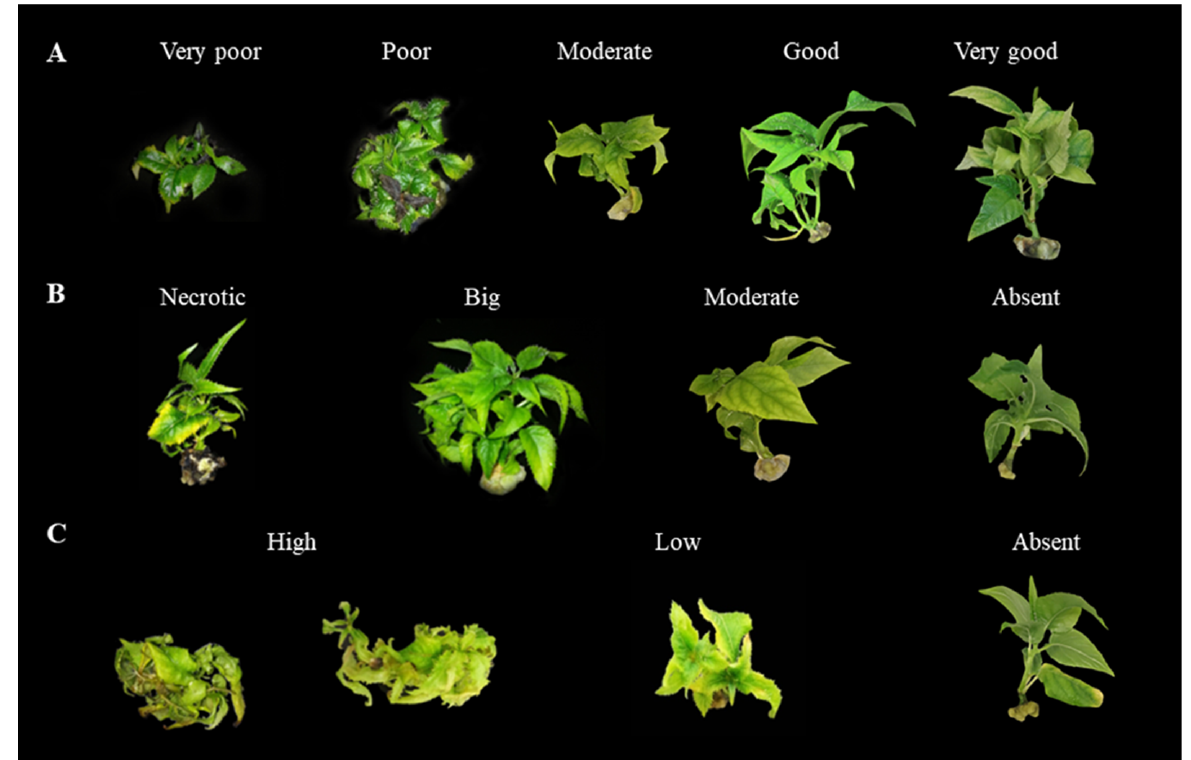
Figure 2. Shoot quality rating ( A ): 1(very poor). 2 (poor). 3 (moderate). 4 (good) and 5 (very good); basal callus formation rating ( B ): 1 necrotic). 2 (big). 3 (moderate) and 4 (absent) and hyperhydricity rating ( C ): 1 (high). 2 (low) and 3 (absent).